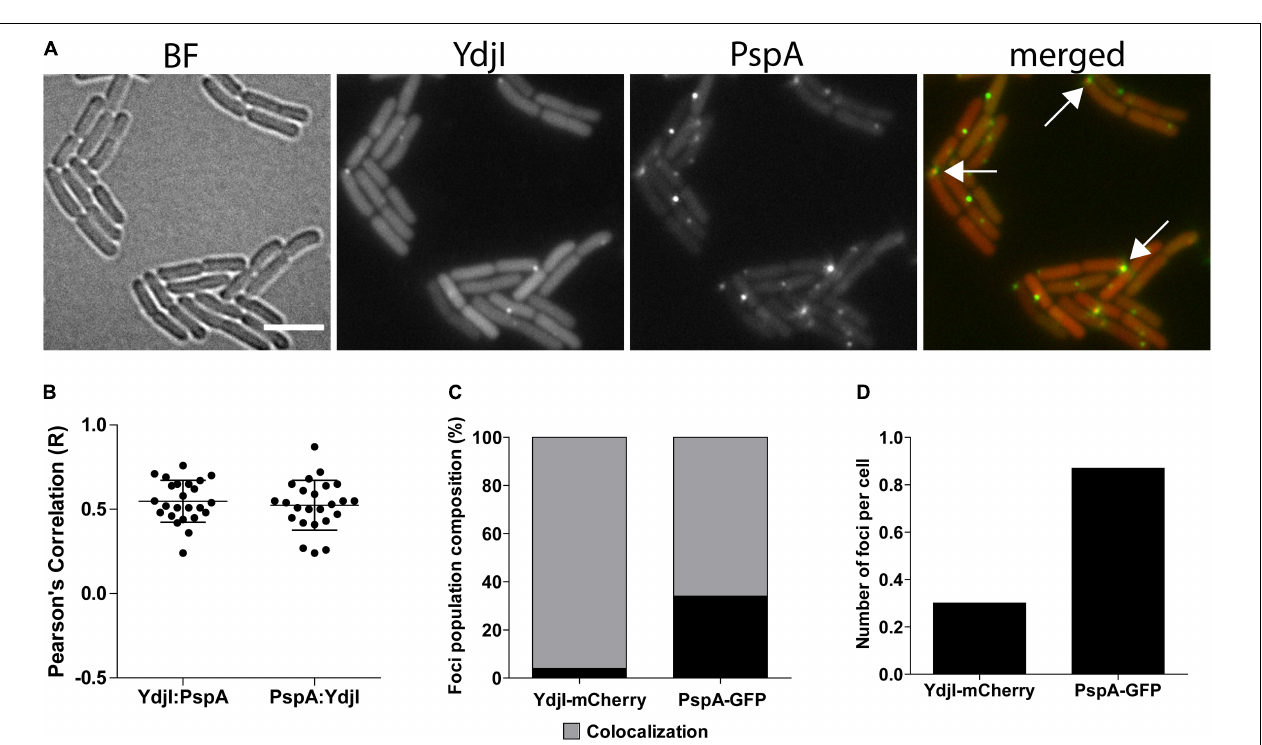
FIGURE 2 | YdjI and PspA intracellular localization. Morphology of the exponentially growing strains labeled with Nile Red in unstressed (upper panel) and in alkali stress conditions (15 mM NaOH), lower panel. (A) YdjI-mNeonGreen and (B) PspA-GFP. Scale bars: 3 µ m.